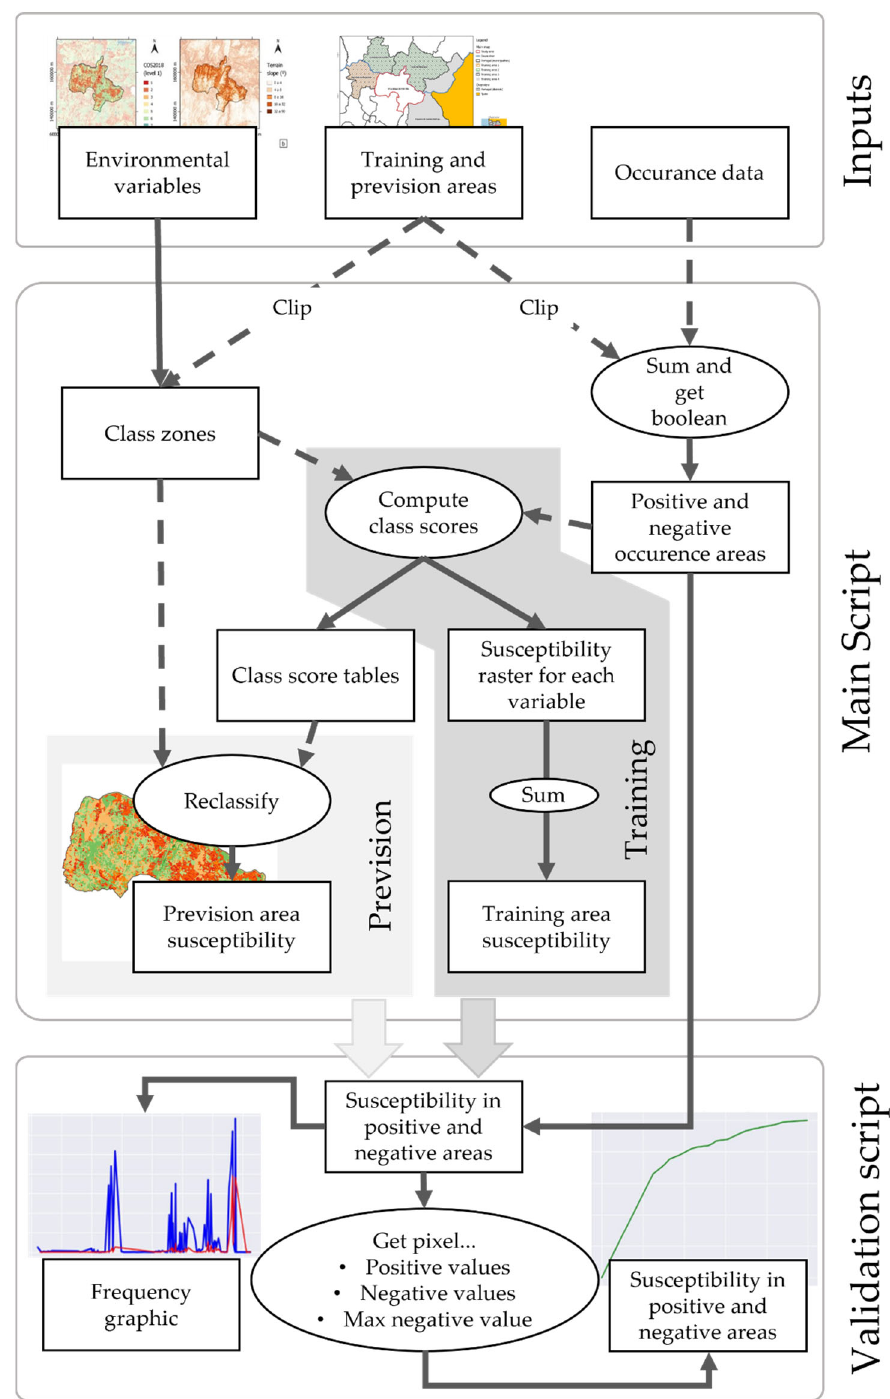
Figure 1. Workflow of the developed GIS